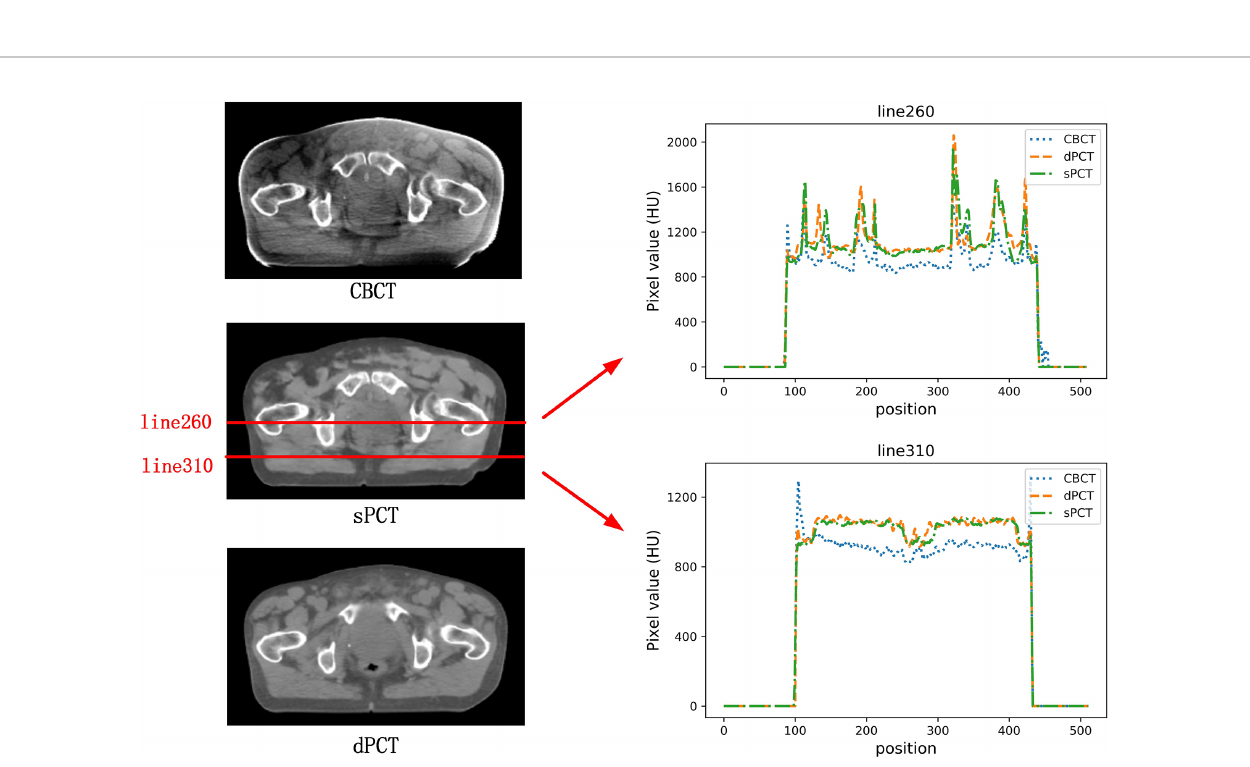
sPCT images obtained by this method has clear organ boundary, fewer scattering artifacts, and good uniformity. Table 1 shows that the average MAE of CBCT and dPCT is 49.96 ± 7.21HU, and the average MAE of sPCT and dPCT is only 14.6 ± 2.39HU.